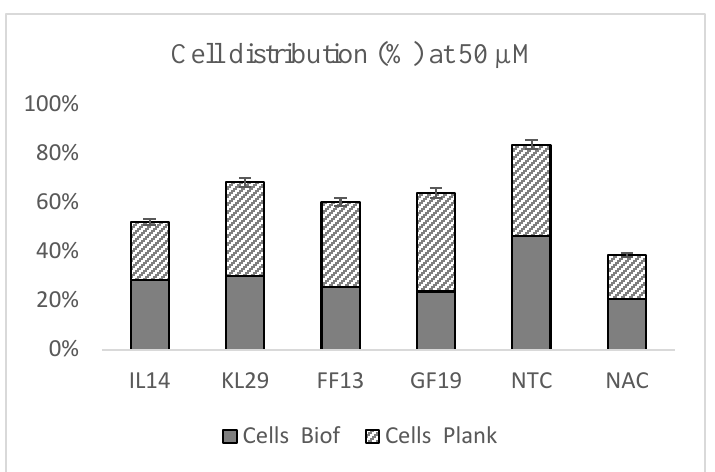
Figure 6. Effect of AMPs on Xf biofilm formation. NTC — untreated Xf cells. NAC — N-acetyl-L-cys- teine-treated Xf cells.